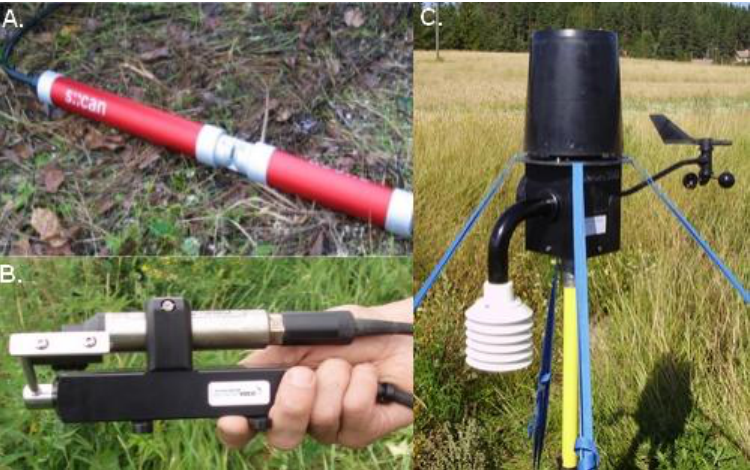
Figure 2. Photographs of the devices used in SoilWeather WSN: ( A ) the spectrometer used in measuring water turbidity and nitrate concentration; ( B ) Turbidity sensor; and ( C )